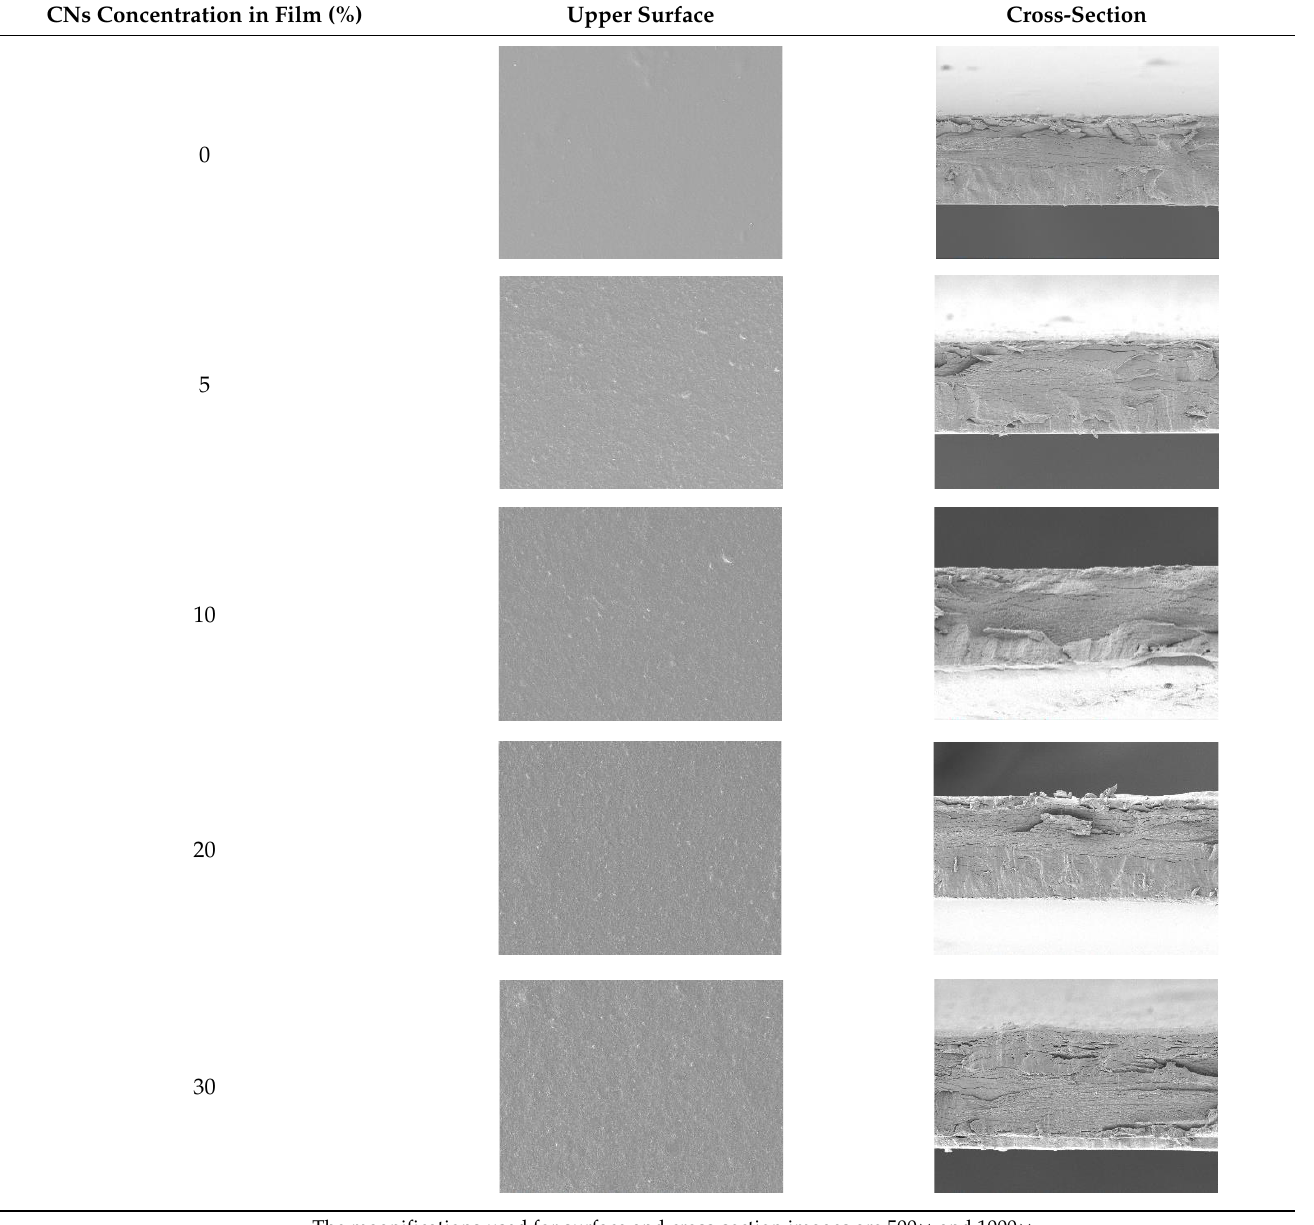
Table 3. Surface and cross-section morphology of smart bilayer films incorporating different concentrations of cellulose nanosphere (CNs).